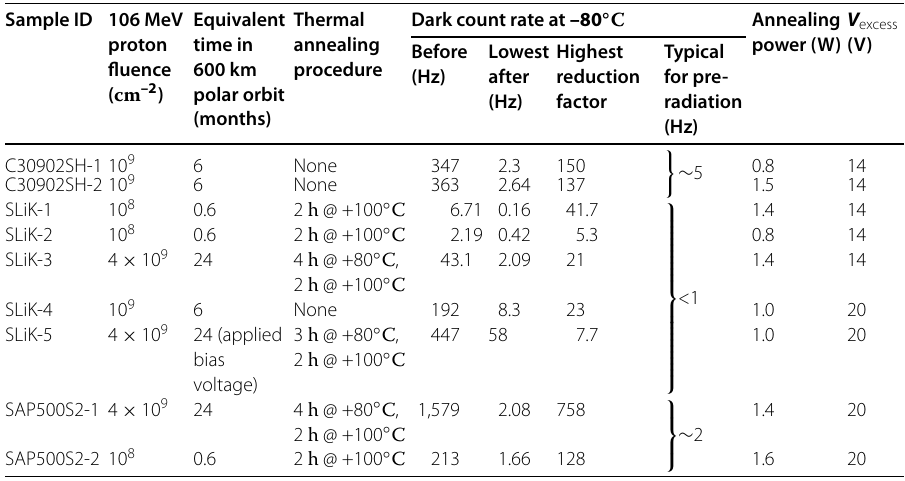
Table 1 Summary of detector samples, applied radiation, previous thermal annealing, and measured results of laser